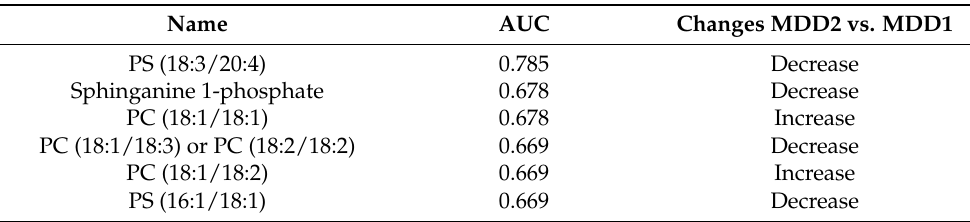
Figure 4. ROC analysis based on area under ROC curve (AUROC)> for PS ( m/z = 806.612). Table 5. The AUC values above 0.650 and the identification of molecules to be considered putative biomarkers of differentiation between MDD1 and MDD2